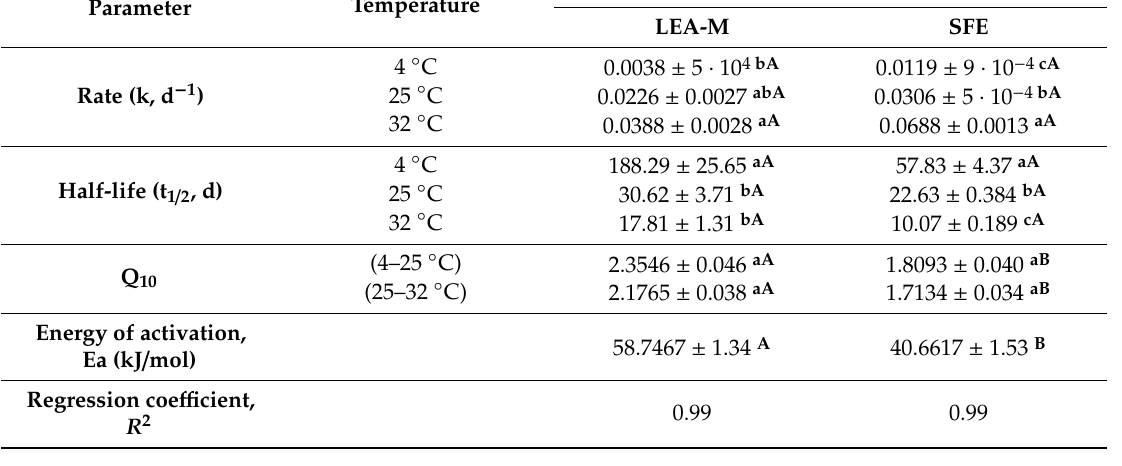
Table 4. E ff ect of storage on anthocyanin-rich extracts. (A) Degradation rate, half-life, the energy of activation and (B) changes in color parameters (L*, a* and b*) of black bean anthocyanins at 4 ◦ C, 25 ◦ C and 32 ◦ C after six weeks. Table 4. Effect of storage on anthocyanin-rich extracts. (A) Degradation rate, half-life, the energy of Table 4. Effect of storage on anthocyanin-rich extracts. (A) Degradation rate, half-life, the energy of Table 4. Effect of storage on anthocyanin-rich extracts. (A) Degradation rate, half-life, the energy of Table 4. Effect of storage on anthocyanin-rich extracts. (A) Degradation rate, half-life, the energy of activation and (B) changes in color parameters (L*, a* and b*) of black bean anthocyanins at 4 °C, 25 °C activation and (B) changes in color parameters (L*, a* and b*) of black bean anthocyanins at 4 °C, 25 °C Table 4. Effect of storage on anthocyanin-rich extracts. (A) Degradation rate, half-life, the energy of Table 4. Effect of storage on anthocyanin-rich extracts. (A) Degradation rate, half-life, the energy of activation and (B) changes in color parameters (L*, a* and b*) of black bean anthocyanins at 4 °C, 25 °C activation and (B) changes in color parameters (L*, a* and b*) of black bean anthocyanins at 4 °C, 25 °C Table 4. Effect of storage on anthocyanin-rich extracts. (A) Degradation rate, half-life, the energy of Table 4. Effect of storage on anthocyanin-rich extracts. (A) Degradation rate, half-life, the energy of and 32 °C after six weeks. and 32 °C after six weeks. activation and (B) changes in color parameters (L*, a* and b*) of black bean anthocyanins at 4 °C, 25 °C Table 4. Effect of storage on anthocyanin-rich extracts. (A) Degradation rate, half-life, the energy of activation and (B) changes in color parameters (L*, a* and b*) of black bean anthocyanins at 4 °C, 25 °C Table 4. Effect of storage on anthocyanin-rich extracts. (A) Degradation rate, half-life, the energy of and 32 °C after six weeks. and 32 °C after six weeks. activation and (B) changes in color parameters (L*, a* and b*) of black bean anthocyanins at 4 °C, 25 °C activation and (B) changes in color parameters (L*, a* and b*) of black bean anthocyanins at 4 °C, 25 °C Table 4. Effect of storage on anthocyanin-rich extracts. (A) Degradation rate, half-life, the energy of Table 4. Effect of storage on anthocyanin-rich extracts. (A) Degradation rate, half-life, the energy of and 32 °C after six weeks. and 32 °C after six weeks. activation and (B) changes in color parameters (L*, a* and b*) of black bean anthocyanins at 4 °C, 25 °C activation and (B) changes in color parameters (L*, a* and b*) of black bean anthocyanins at 4 °C, 25 °C and 32 °C after six weeks. and 32 °C after six weeks. activation and (B) changes in color parameters (L*, a* and b*) of black bean anthocyanins at 4 °C, 25 °C activation and (B) changes in color parameters (L*, a* and b*) of black bean anthocyanins at 4 °C, 25 °C and 32 °C after six weeks. and 32 °C after six weeks. and 32 °C after six weeks.